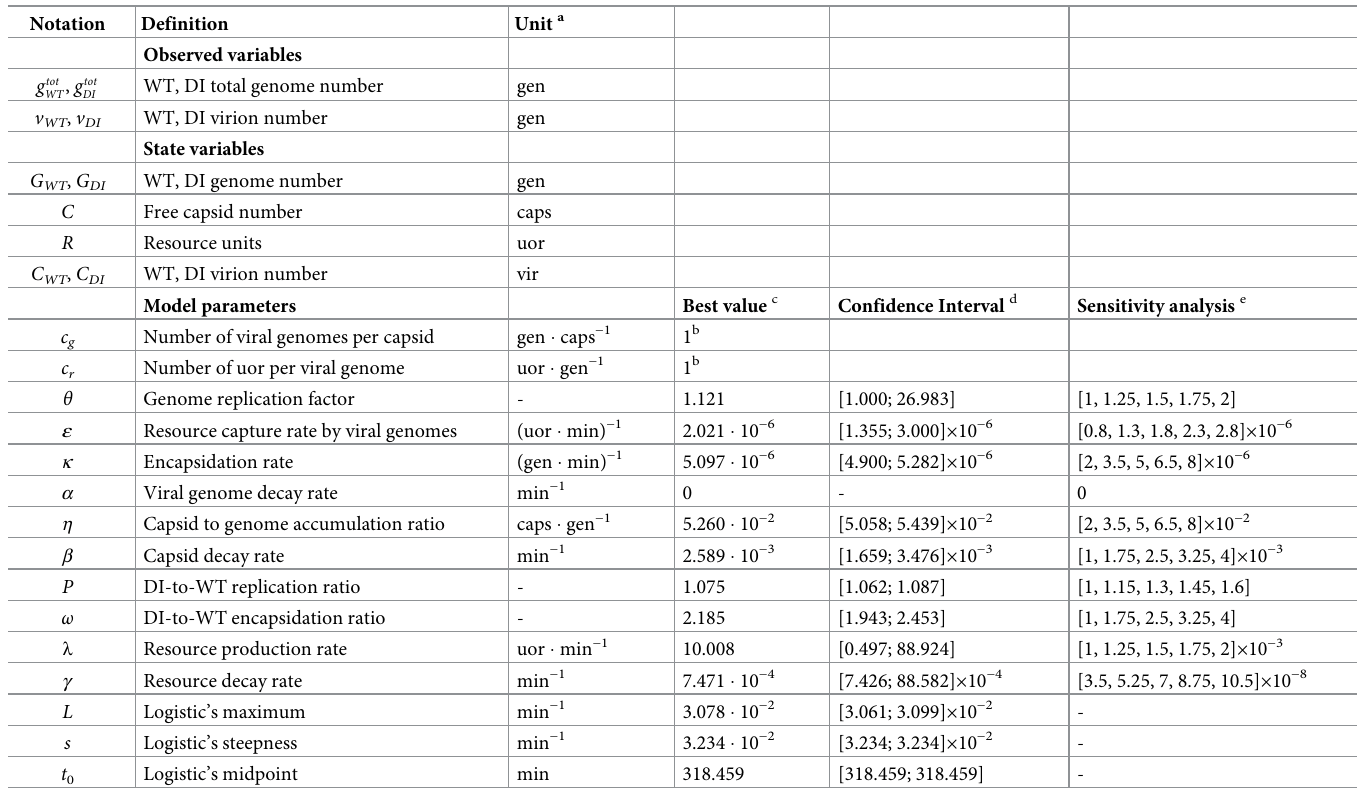
Table 1. Notations used in the model and model